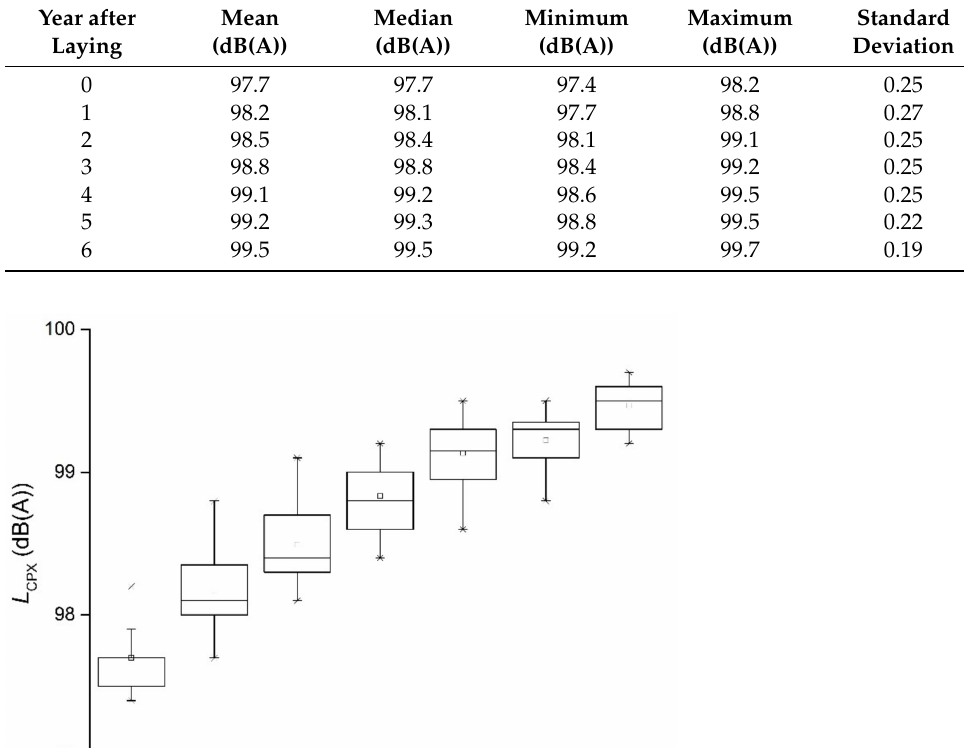
Table 2. Basic statistical analysis of noise values for the stone mastic asphalt surface with increased resistance to permanent deformation with the highest grain size of 11 mm (SMA 11S).